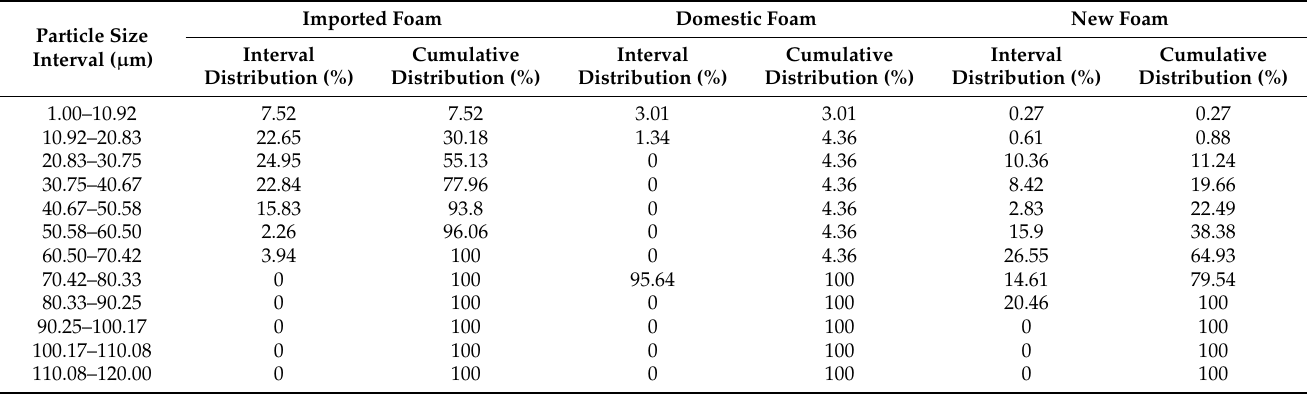
Table 6. Particle size distribution of three different foams.